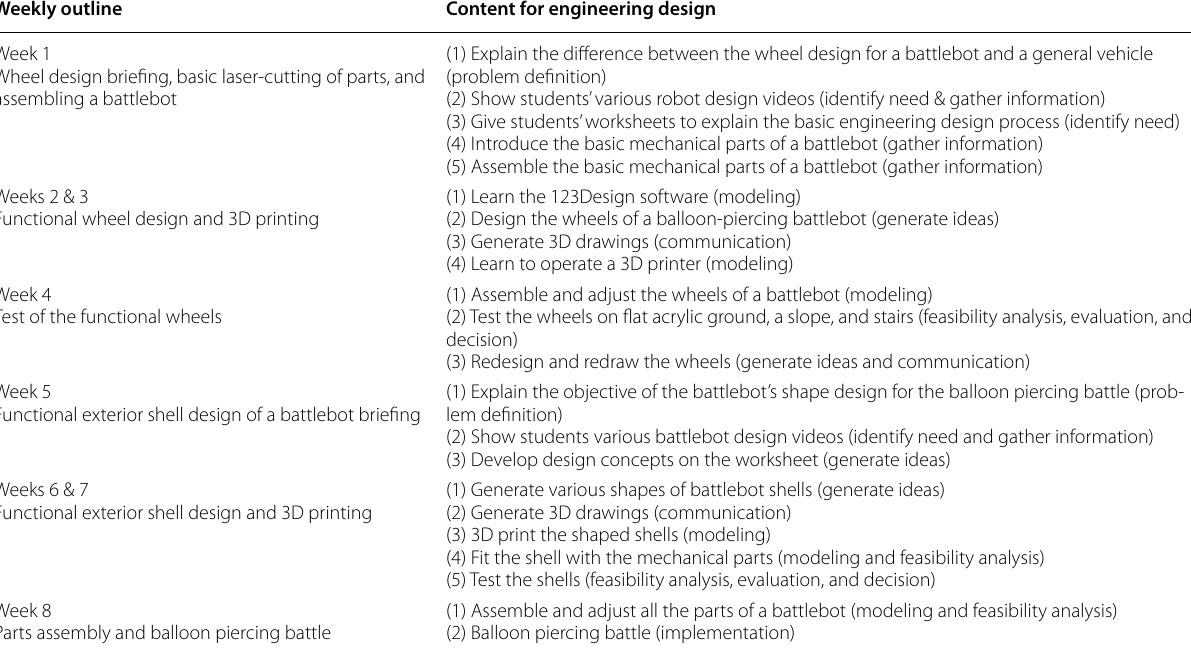
Table 1 Content descriptions of the battlebot design course Weekly